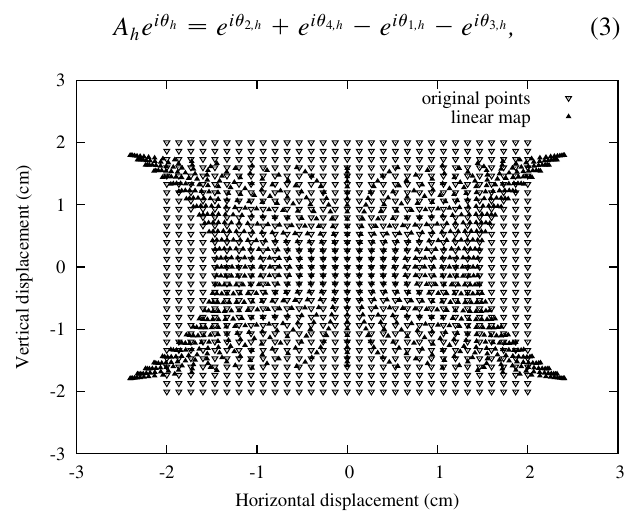
FIG. 2. Linearized map distortion in CESR arc BPM with approximately elliptical cross section.